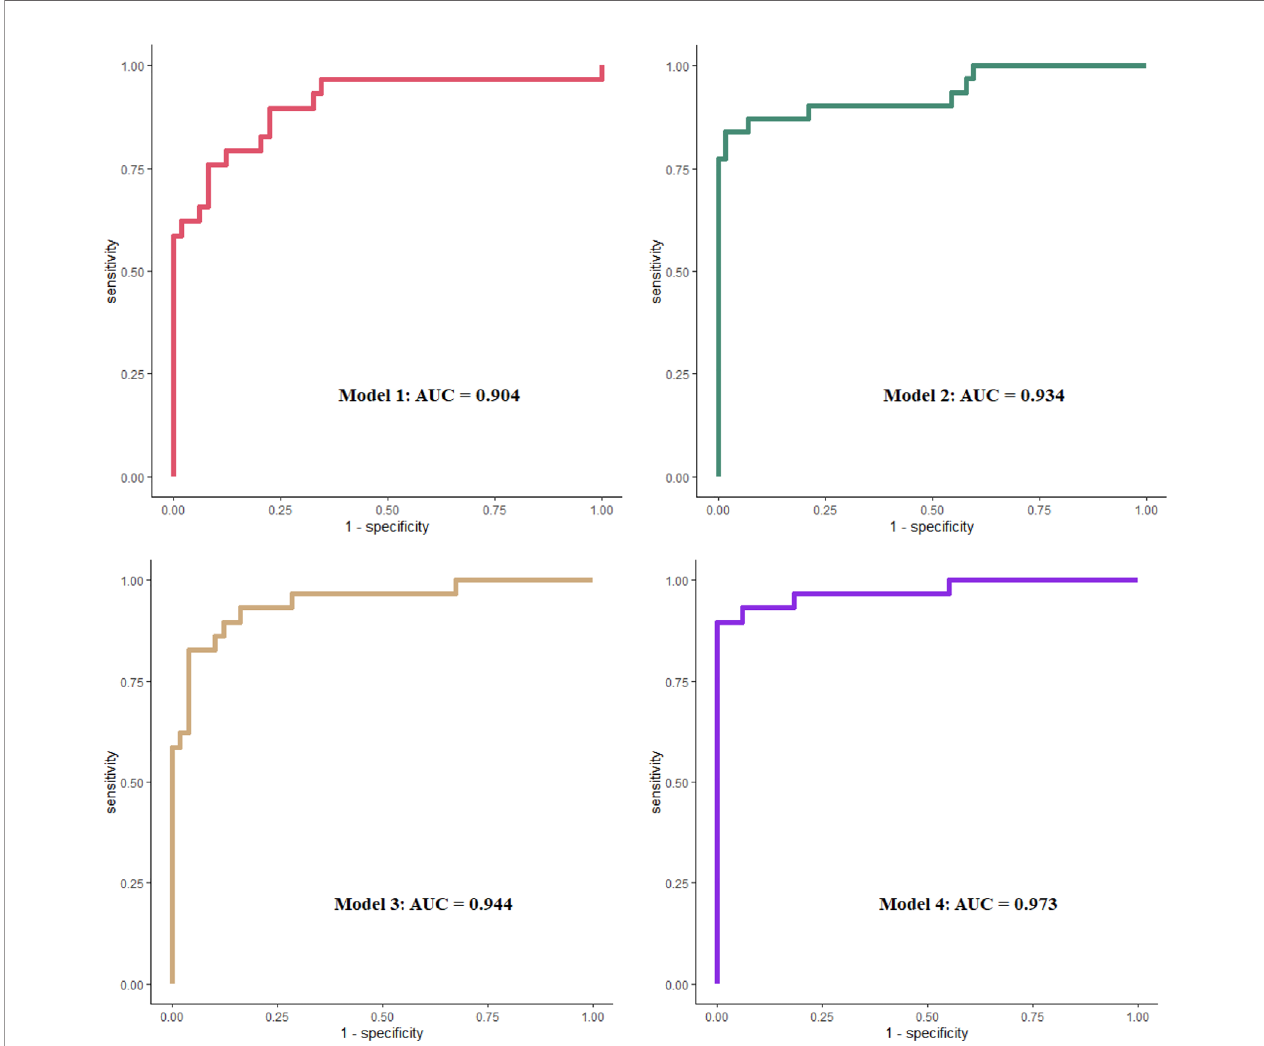
FIGURE 5 | ROC curves in evaluation different models to predict ESKD. Model 1 included urinary MBL, Bb, C4d, C3a, C5a, and sC5b-9, all corrected by urine creatinine. Model 2 included Scr, UTP, and crescent percentage. Model 3 included covariates in model 1 plus crescent percentage. Model 4 included covariates in model 1 plus model 2. All covariates were analyzed as continuous data. ROC, receiver operating characteristic; ESKD, end-stage kidney disease; MBL, mannose- binding lectin; Scr, serum